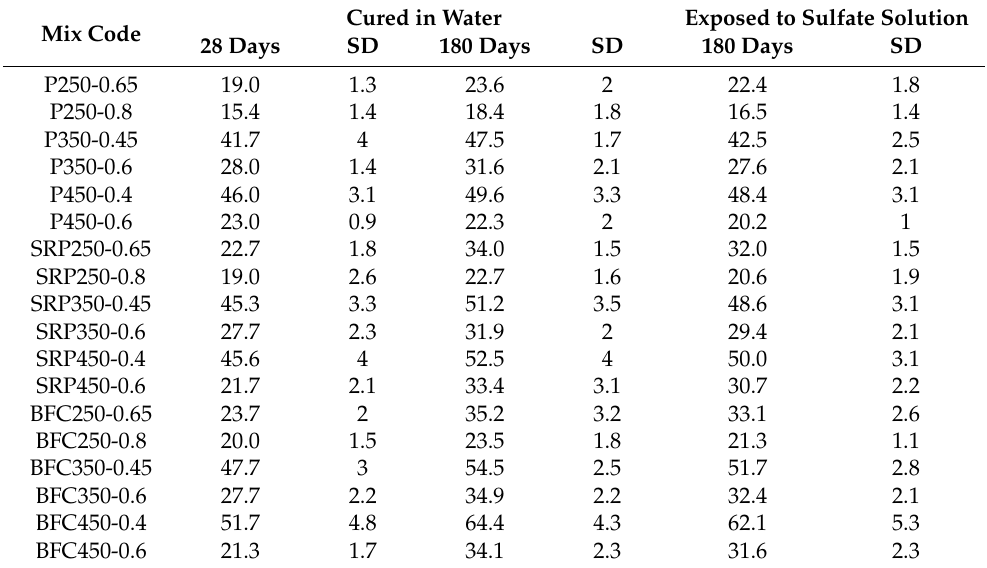
Table 5. Compressive strength results of all mixes in